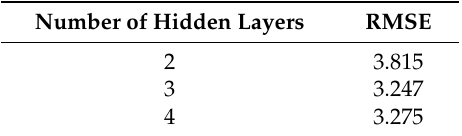
Table 2. RMSE results of each stacked hidden layer model.